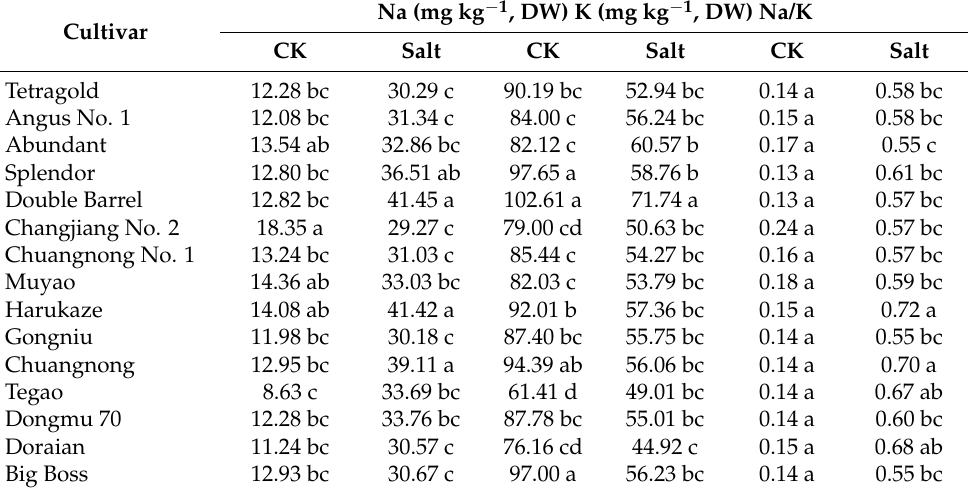
Table 1. The Na and K concentrations and Na/K ratio in the shoot for each cultivar under control (CK) and 200 mM NaCl treatment